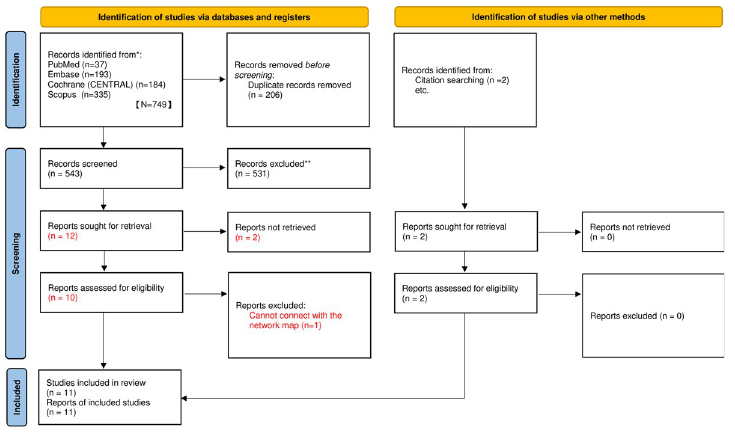
Fig 1. Flow diagram of included